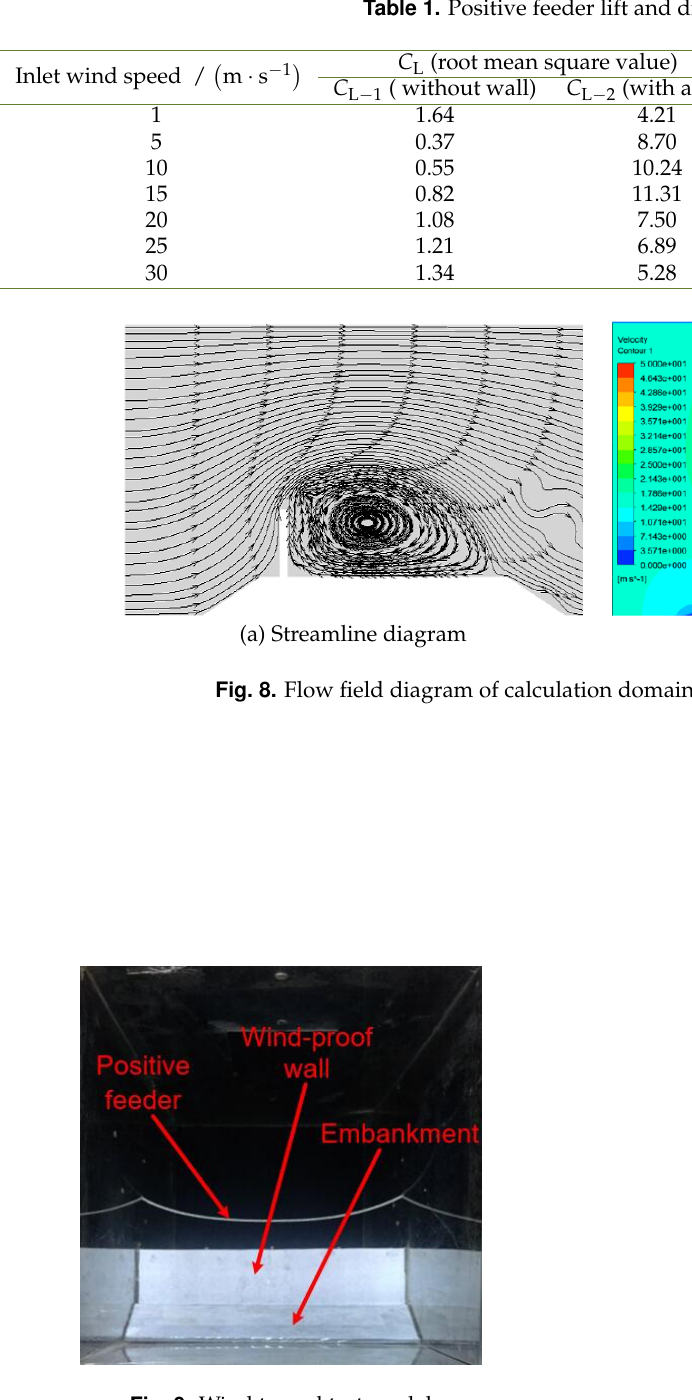
Fig. 9. Wind tunnel test model Fig. 10. Wind speed measuring